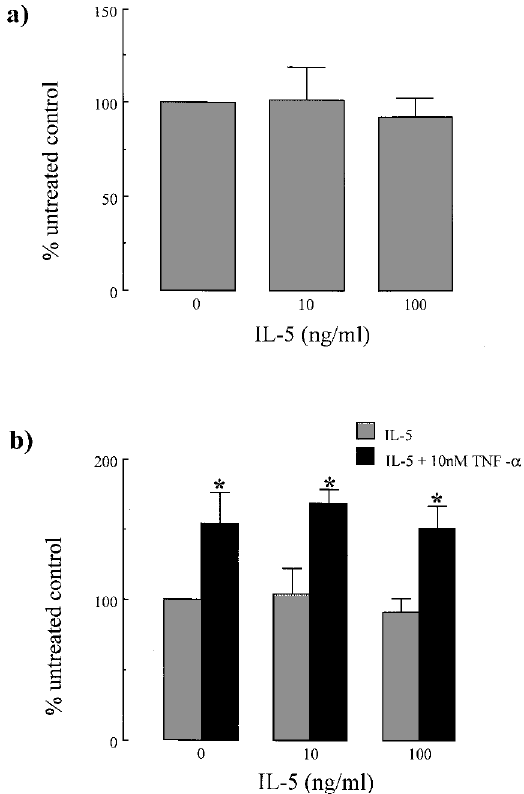
FIG. 4. The effect of IL-5 on eosinophil adhesion to airway smooth muscle cells: ( a ) after 20h of co-culture, and ( b ) 2h of co-culture alone and in combination with 10nM TNF- a added to the smooth muscle cells 24h previously. Values are means±SE; Con, untreated control; *, significantly different from untreated control ( p < 0.05, n =